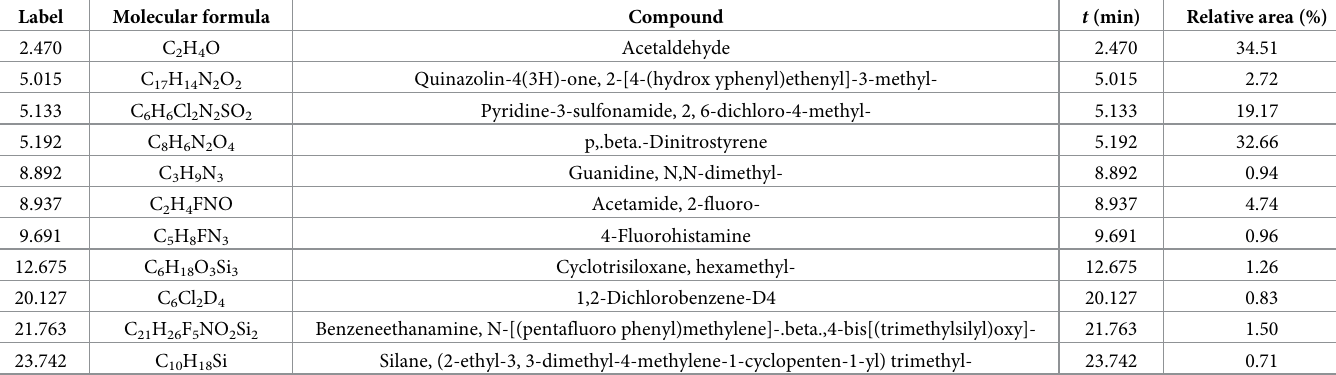
Table 2. The parameters and the possible organic compound results from the GC-MS. Label Molecular